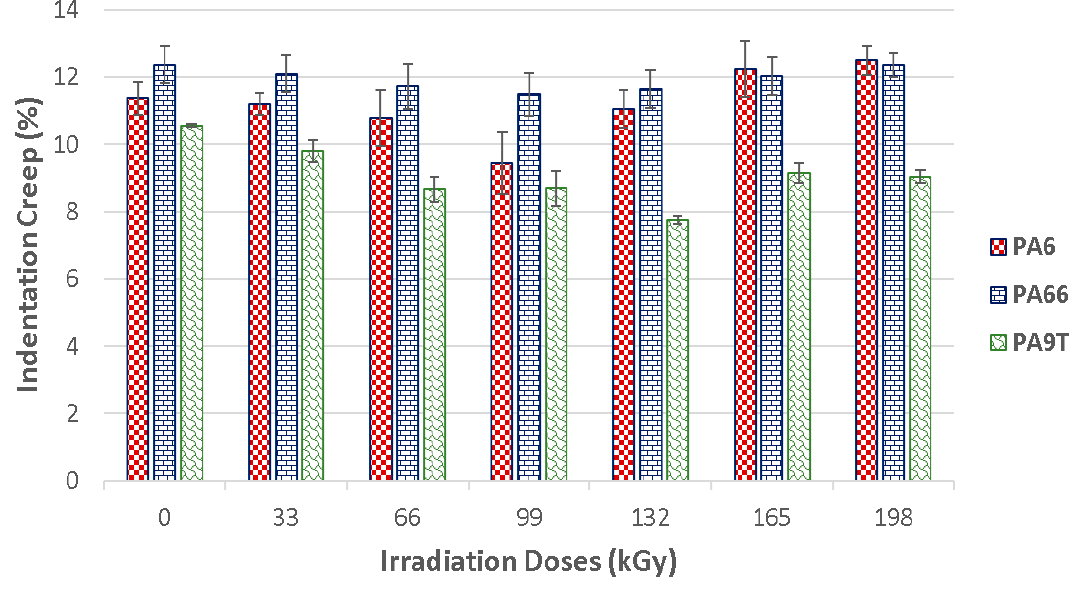
Figure 10. Indentation creep (C IT ) of irradiated PA 6, PA 66 and PA 9T.